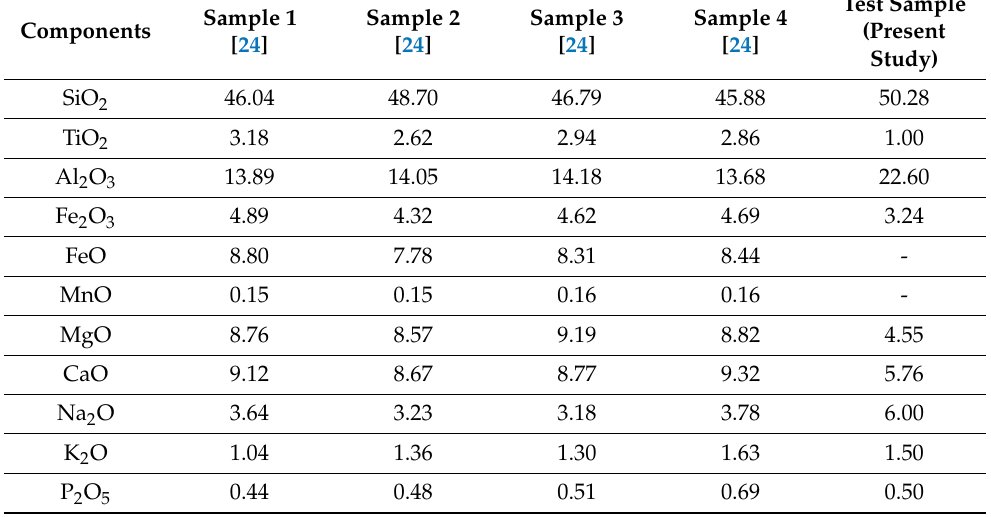
Table 2. Chemical analyses of Diyarbakır basalt aggregate